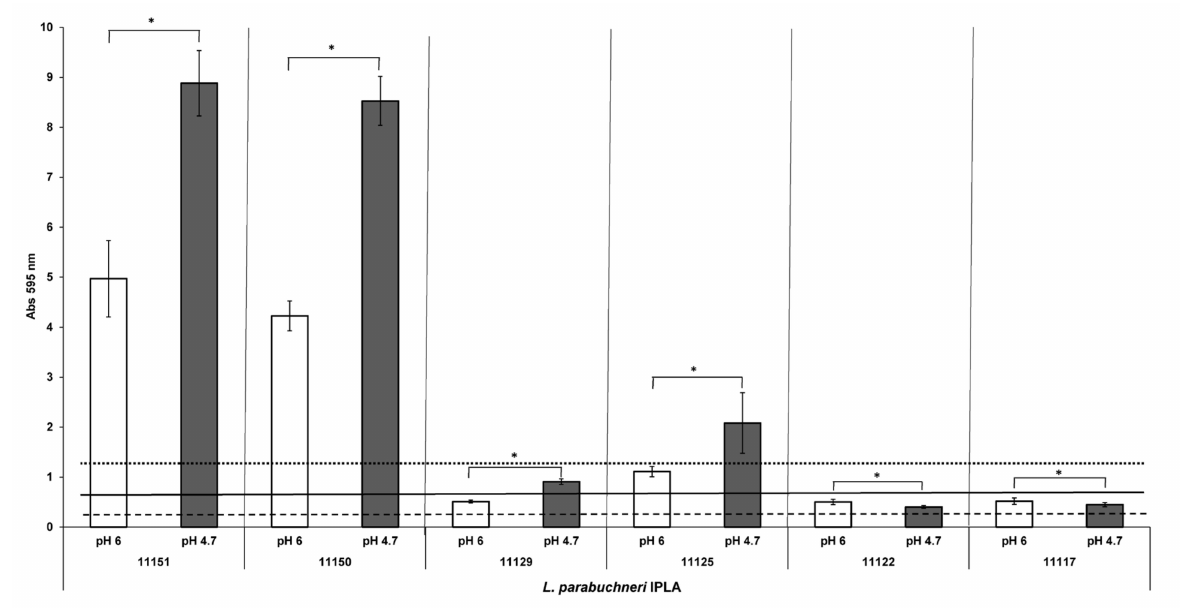
Figure 5. Biofilm-producing capacity on polystyrene of the biogenic amine-producing Lentilactobacil- lus strains incubated with MRS at pH 4.7 and 6. The strains were incubated for 48 h at 37 ◦ C. Data represent means ± SD (error bars) of three experiments. Values marked with * differ significantly. The producer/nonproducer cut-off (weak producer) is signaled by the dashed line (ODc), the solid line is 2 × ODc (moderate producer) and the dotted line 4 × ODc (strong